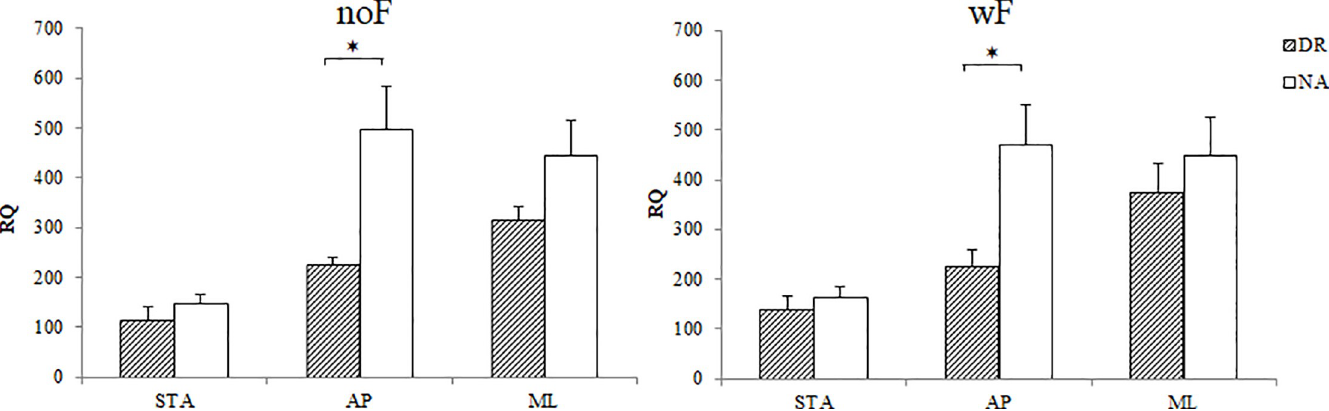
Fig 5. Romberg Quotient (RQ) for DR and NA groups for each of the three balances (STA, AP, ML) on COP surface (with and without foam). Data are presented as mean and standard error ( � p < 0.05).